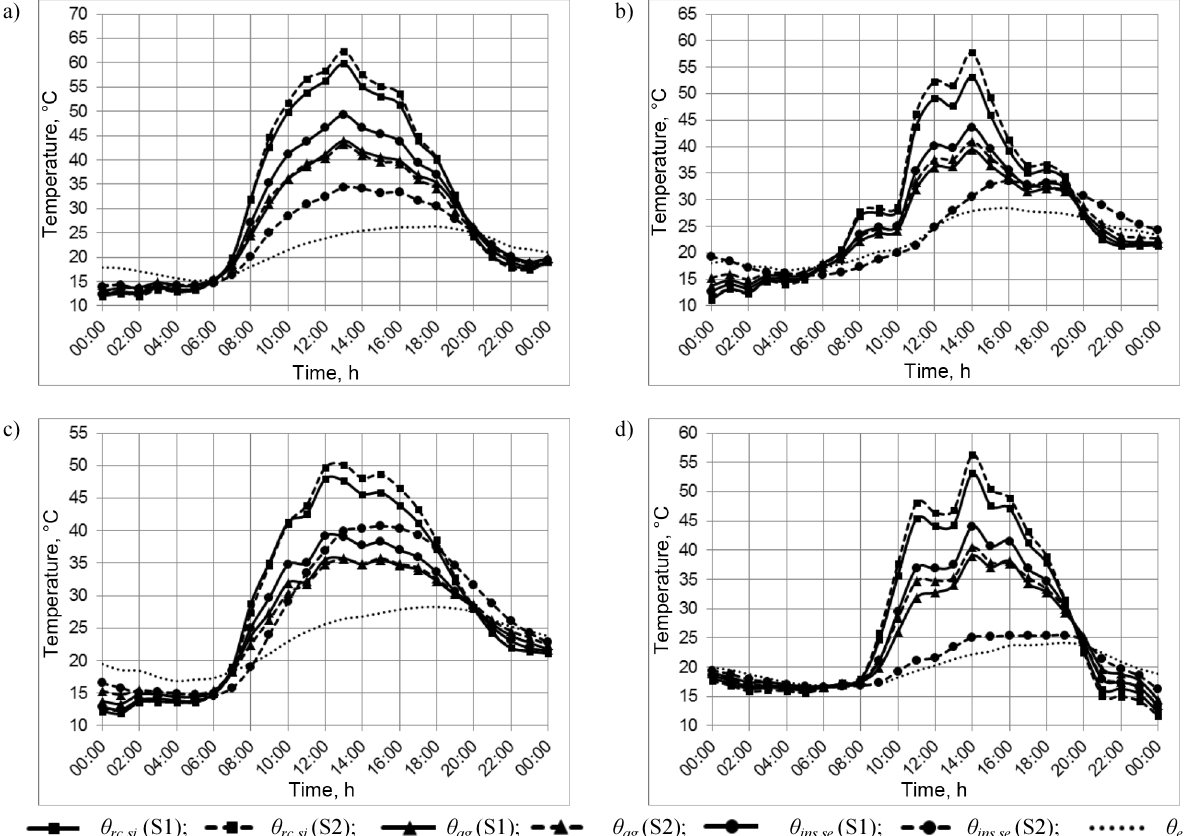
Fig. 3. Temperature variation of the roof coating θ rc.si , ventilated air gap of the roof θ ag , external surface of the thermal insulation layer θ ins.se and exterior air θ e during different experiments: a) Exp. 2; b) Exp. 3; c) Exp. 4; d) Exp. 5